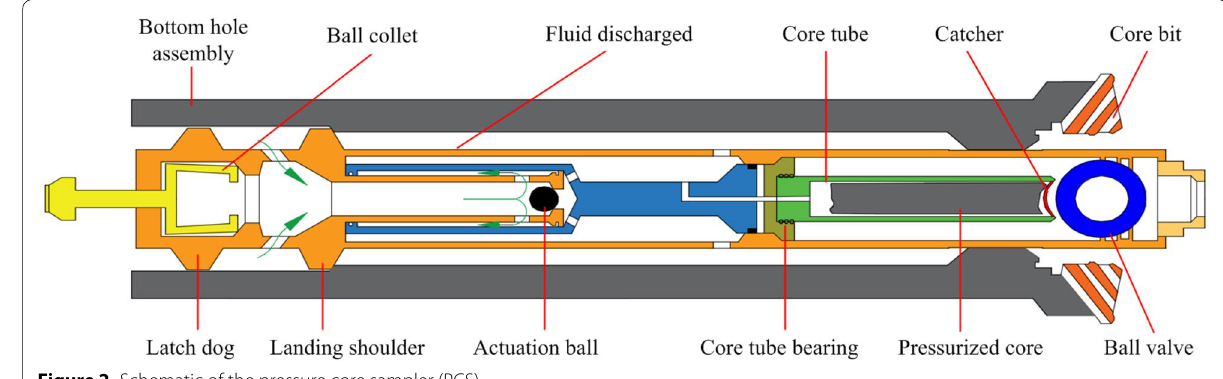
Figure 2 Schematic of the pressure core sampler (PCS)